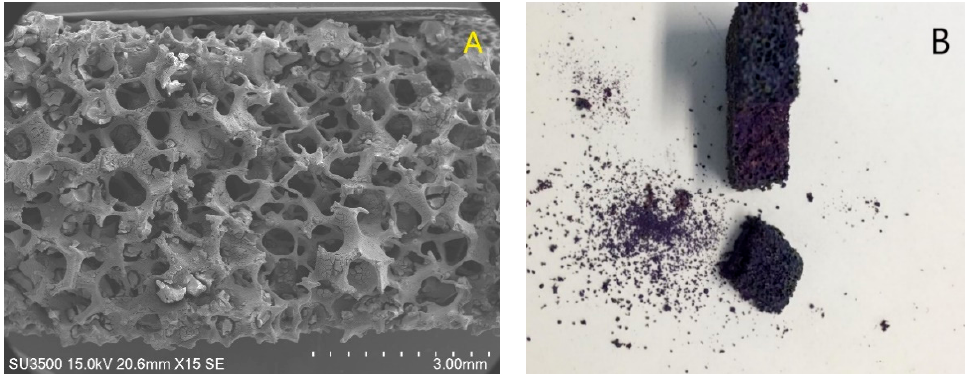
Figure 2. ( A ) SEM image of the total size of the coated foam and ( B ) photograph of stainless-steel foam covered with TiO 2 -anthocyanin 25 Ma.